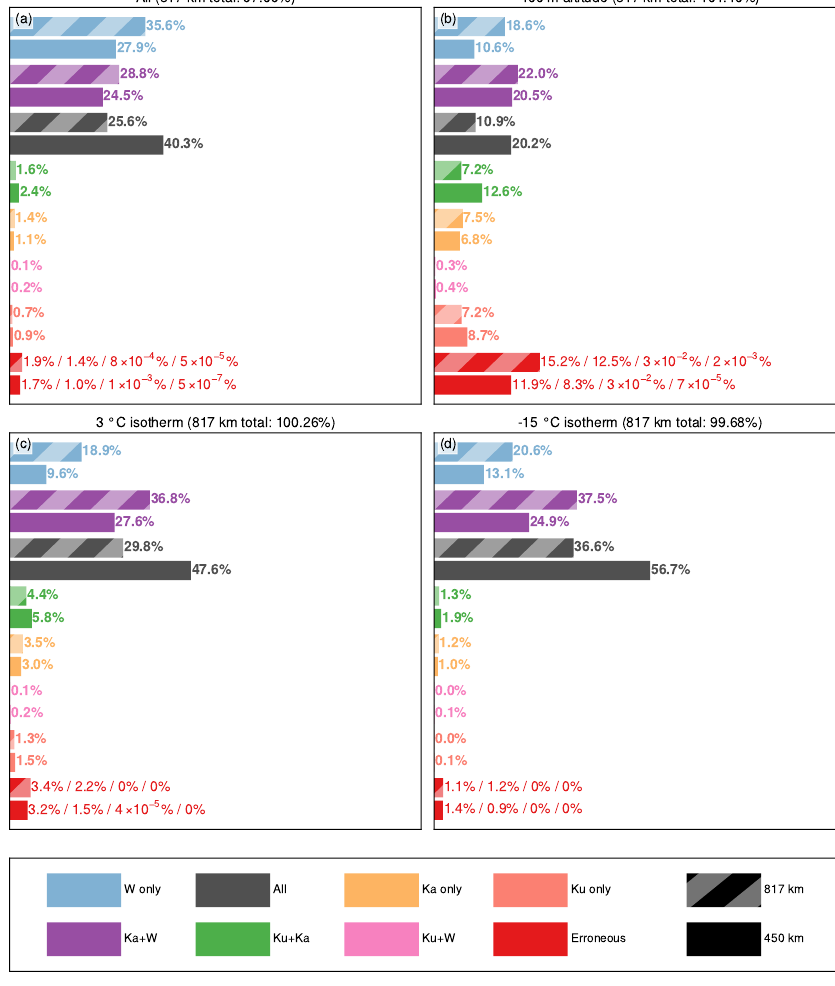
gradients of reflectivity give rise to NUBF, and the heavy precipitation in these systems often causes attenuation and multiple scattering effects. The other source of errors occurs when a cloud base or top is located in the bin vertically adja- cent to the 400 m level. When this occurs, the nonzero radar pulse length causes signal to bleed to the neighboring range bins. Hence, the difference between the ideal and measured radar reflectivity is large, and the bin is marked as suffering from NUBF. This results in the relatively uniform areas of the map marked as erroneous, which are found mainly at the high latitudes. gests that of the points where only the W band is able to